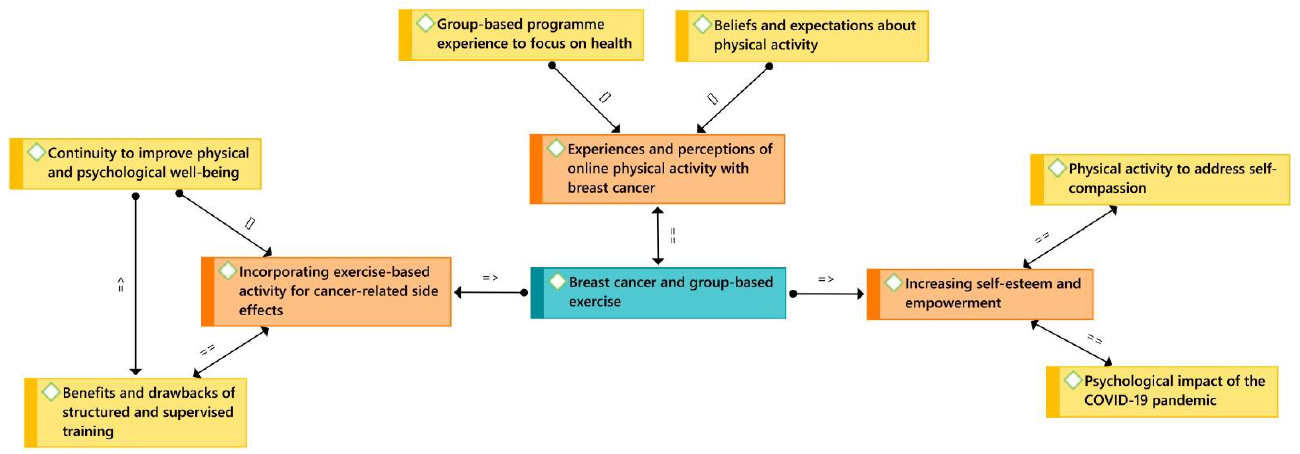
Figure 1. Conceptual map based on female breast cancer patients’ experiences with physical exercise during the COVID-19 pandemic ([] — is part of; = = — is associated with; = > — is a cause of).